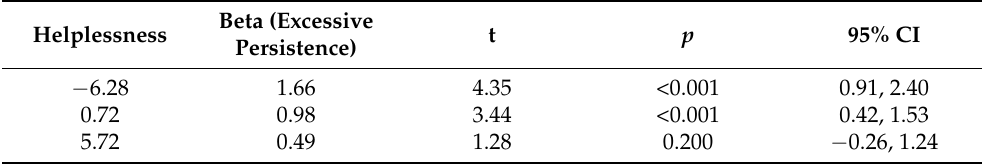
Table 8. Conditional effects of excessive persistence on fibromyalgia impact at different values of